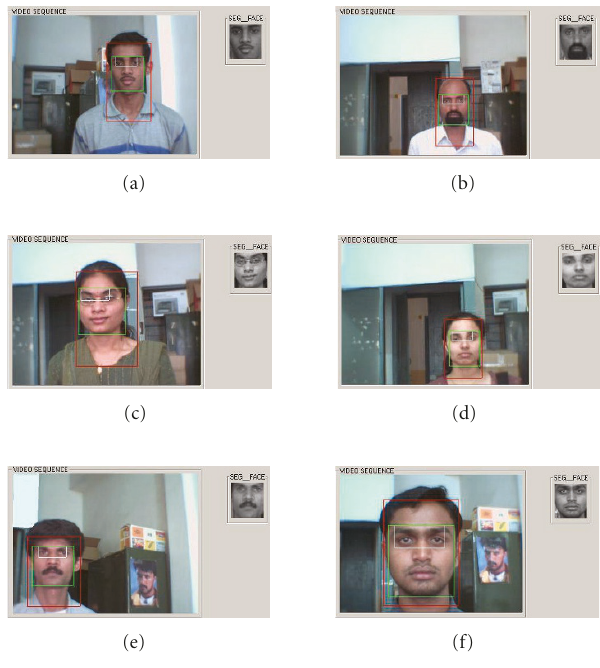
Figure 12: Results of face segmentation using the proposed method.